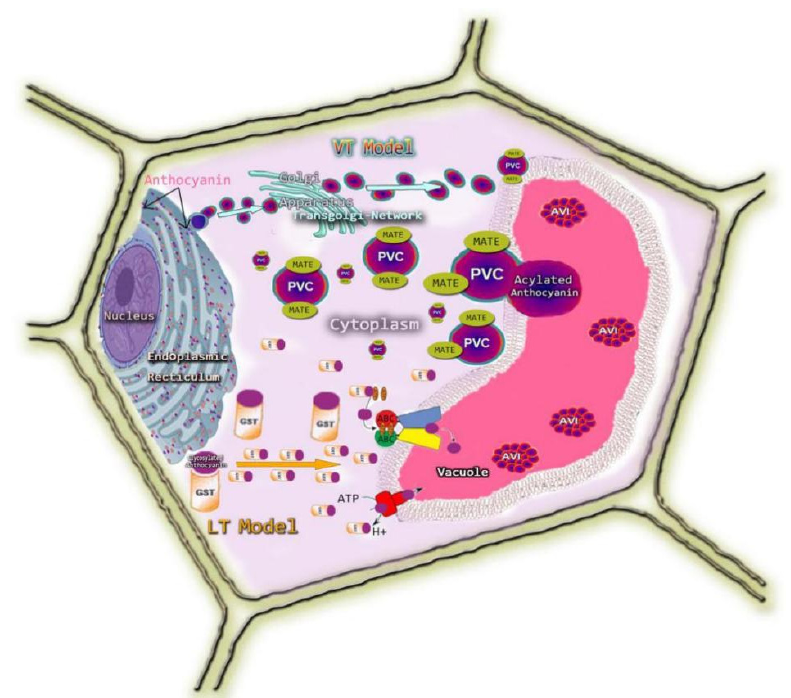
Figure 4. Conceptual Models of the Transport mechanisms of anthocyanin in rice.